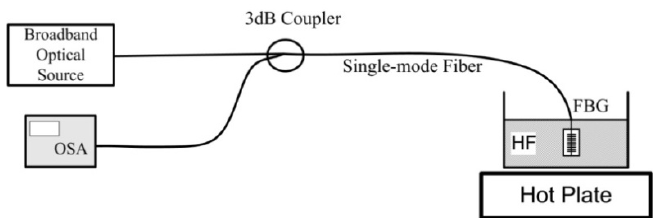
Figure 3. Experimental setup for cladding-etching process.